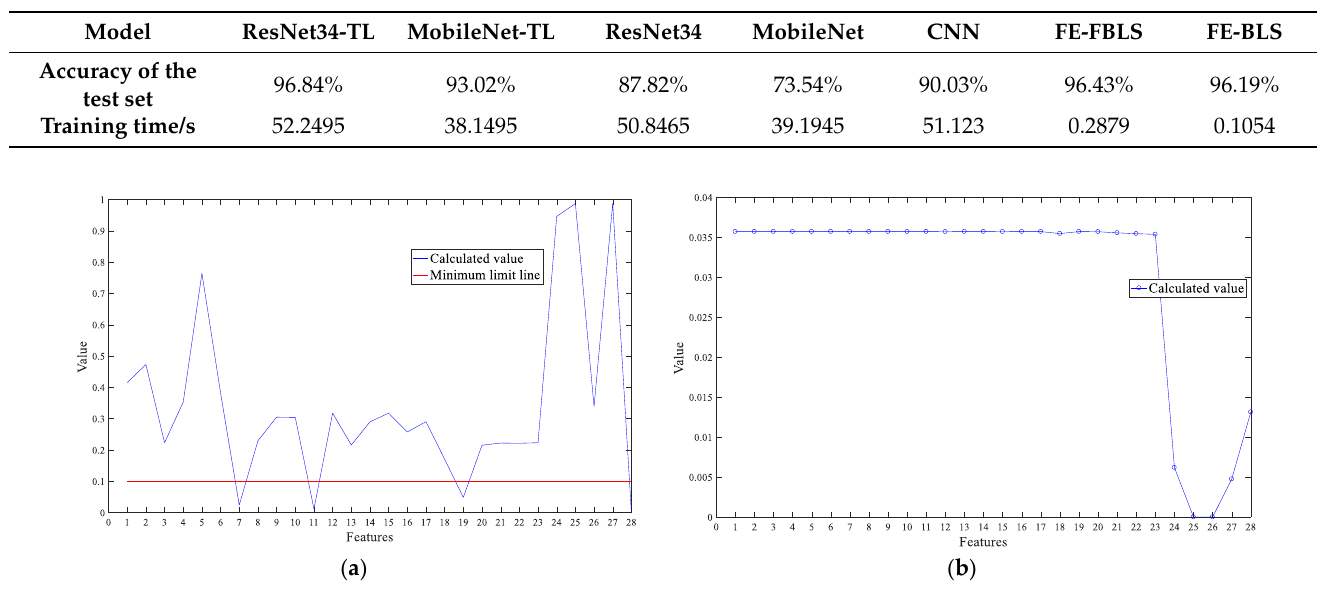
Figure 6. Value of each characteristic calculation index under Dataset 1: ( a ) Correlation; ( b ) robustness.